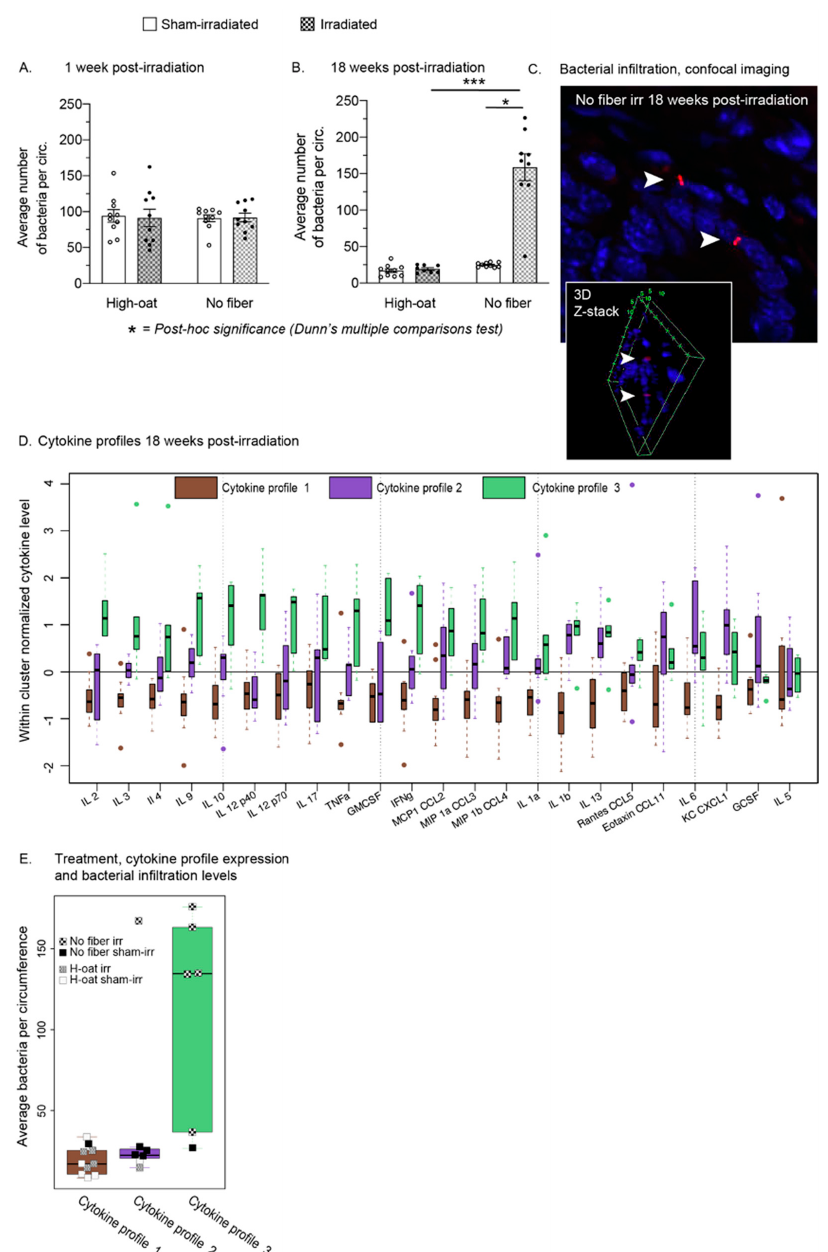
Figure 6. The average number of bacteria per circumference at 1 week and 18 weeks after irradiation. ( A ). Quantification of bacteria in the mucosa one week after irradiation confirmed that bacterial